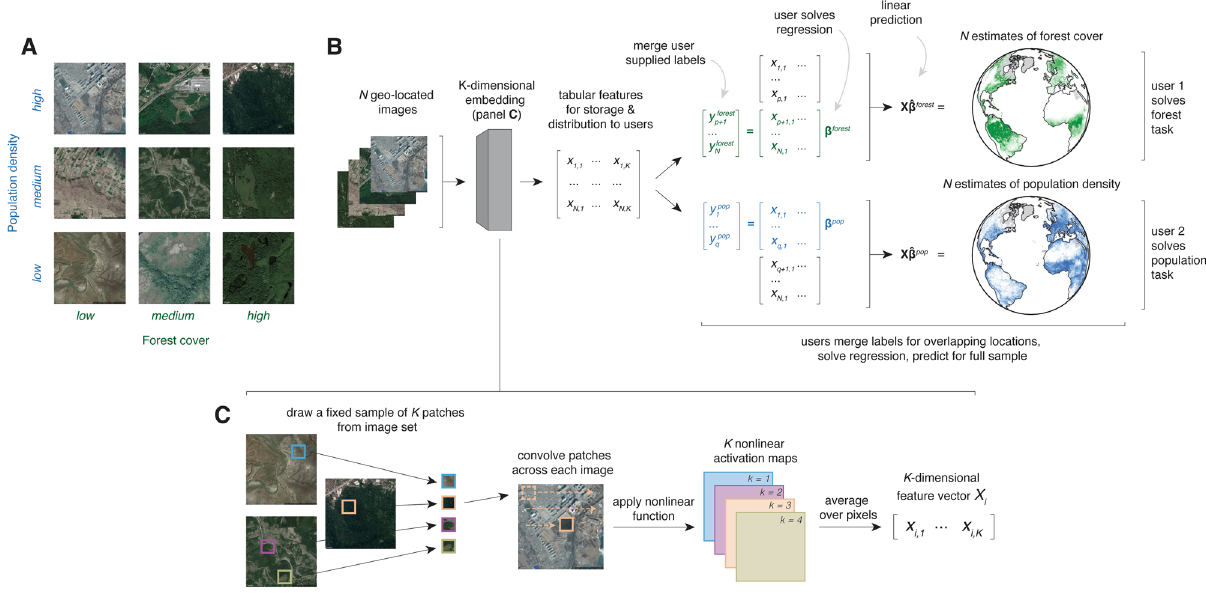
Fig. 1 A generalizable approach to combining satellite imagery with machine learning (SIML) without users handling images. MOSAIKS is designed to solve an unlimited number of tasks at planet-scale quickly. After a one-time unsupervised image featurization using random convolutional features, MOSAIKS centrally stores and distributes task-agnostic features to users, each of whom generates predictions in a new context. a Satellite imagery is shared across multiple potential tasks. For example, nine images from the US sample are ordered based on population density and forest cover, both of which have distinct identifying features that are observable in each image. b Schematic of the MOSAIKS process. N images are transformed using random convolutional features into a compressed and highly descriptive K -dimensional feature vector before labels are known. Once features are computed, they can be stored in tabular form (matrix X ) and used for unlimited tasks without recomputation. Users interested in a new task ( s ) merge their own labels ( y s ) to features for training. Here, user 1 has forest cover labels for locations p + 1 to N and user 2 has population density labels for locations 1 to q . Each user then solves a single linear regression for β s . Linear prediction using β s and the full sample of MOSAIKS features X then generates SIML estimates for label values at all locations. Generalizability allows different users to solve different tasks using an identical procedure and the same table of features — differing only in the user-supplied label data for training. Each task can be solved by a user on a desktop computer in minutes without users ever manipulating the imagery. c Illustration of the one-time unsupervised computation of random convolutional features (Methods and Supplementary Note 2.3). K patches are randomly sampled from across the N images. Each patch is convolved over each image, generating a nonlinear activation map for each patch. Activation maps are averaged over pixels to generate a single K -dimensional feature vector for each